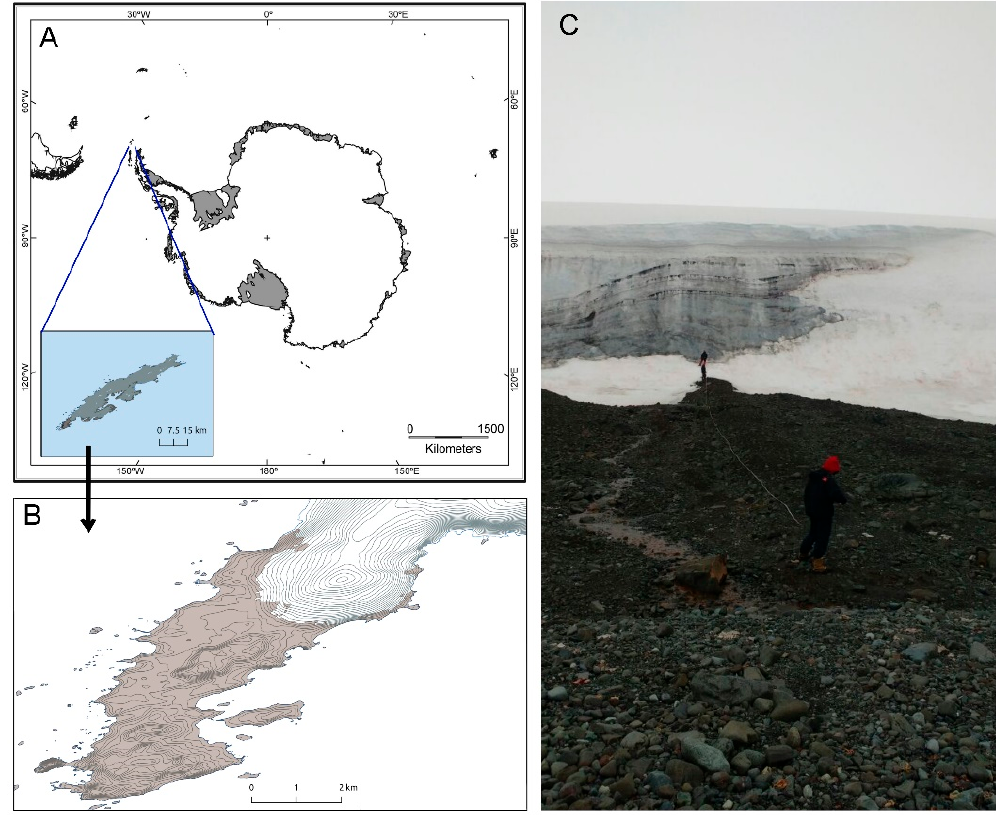
Figure 1. Collins Glacier (Fildes Peninsula, South Shetlands Archipelago, King George Island, Maritime Antarctica). ( A , B ) Map of the sampling region; ( C ) sampling.